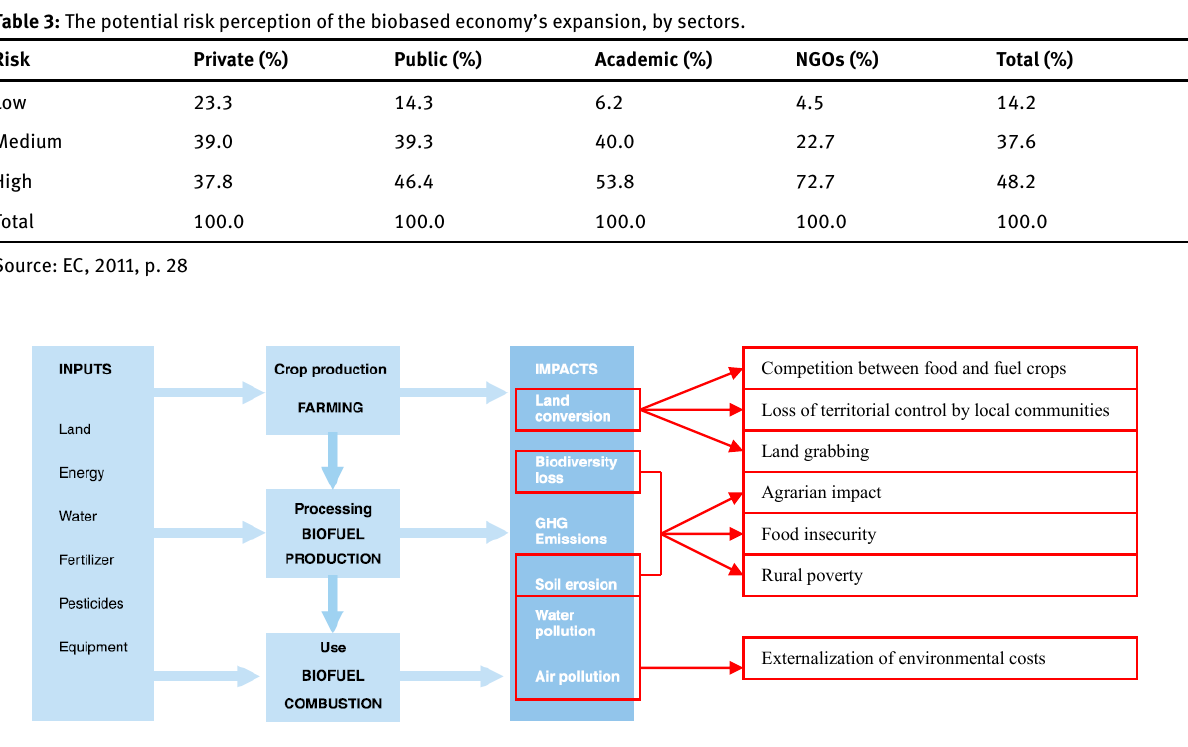
Fig. 4 – A general biofuel frame with inputs, environmental impacts and connected socioeconomic implications. Source: UNEP, 2009, p. 51, with update on data M. Ciervo and S. Schmitz (submitted for